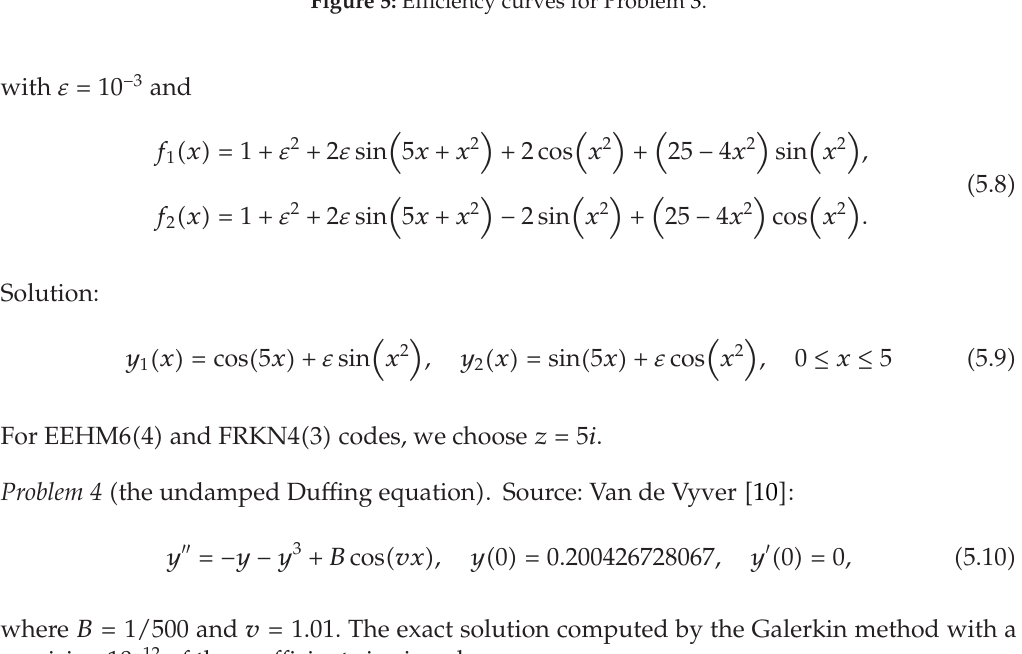
Figure 5: E ffi ciency curves for Problem